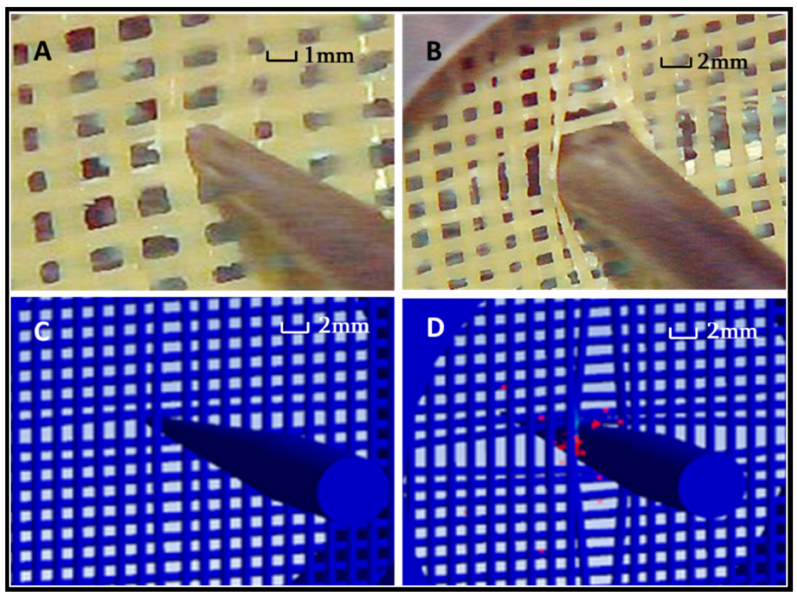
Figure 15. Comparisons between the results obtained using the finite element method (FEM) with anisotropy parameters and the experimental results. (( A ) shows the needle contacted material in the experiment, ( B ) shows the needle completely penetrated the material in the experiment, ( C ) shows the needle contacted material in the simulation experiment, ( D ) shows the needle completely penetrated the material in the simulation